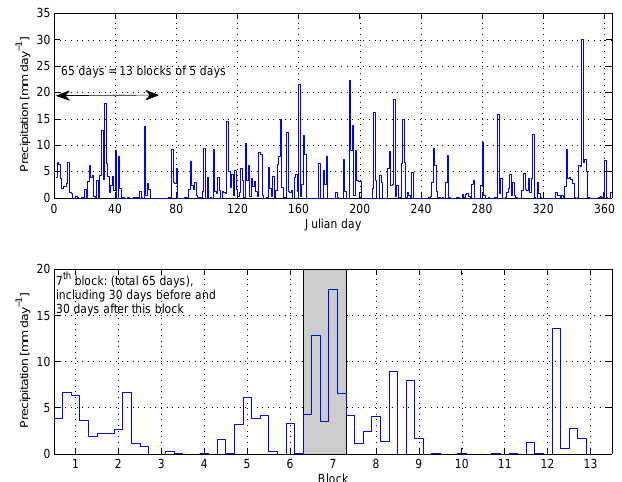
Fig. 3. Schematisation of the division of a year into 73 blocks of 5 days each for which the a and b parameters are determined. Top: daily precipitation throughout the year; Bottom: first 65 days of the year resulting in 13 blocks of 5 days